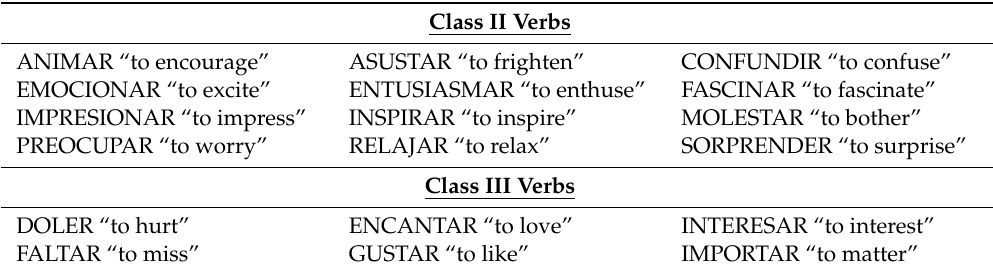
Table 2. Verbs used in experimental tasks 7